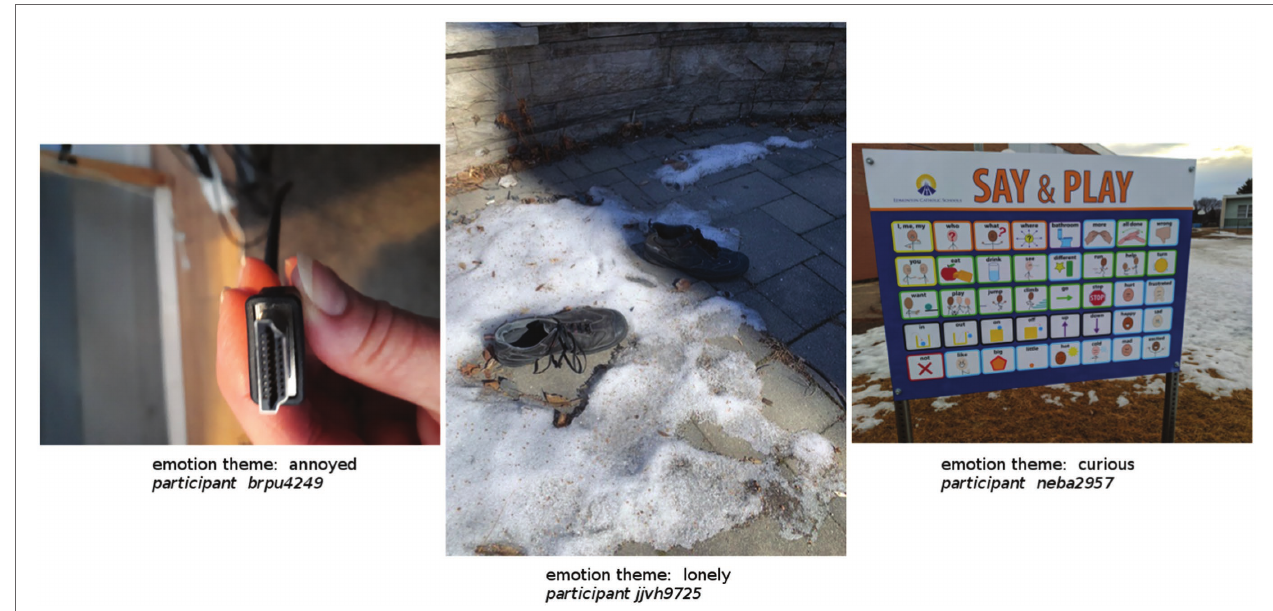
FIGURE 5 | Selection of photos as illustrative sample of the top three emotion themes most likely to be associated with built